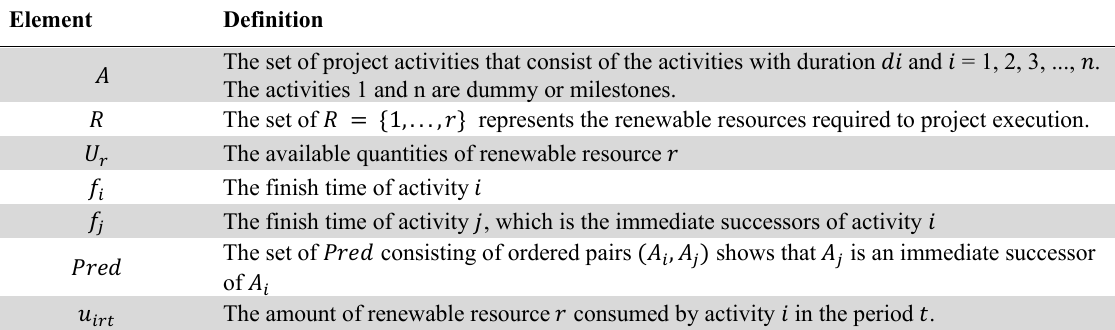
The definitions of employed elements in the standard RCPSP Element